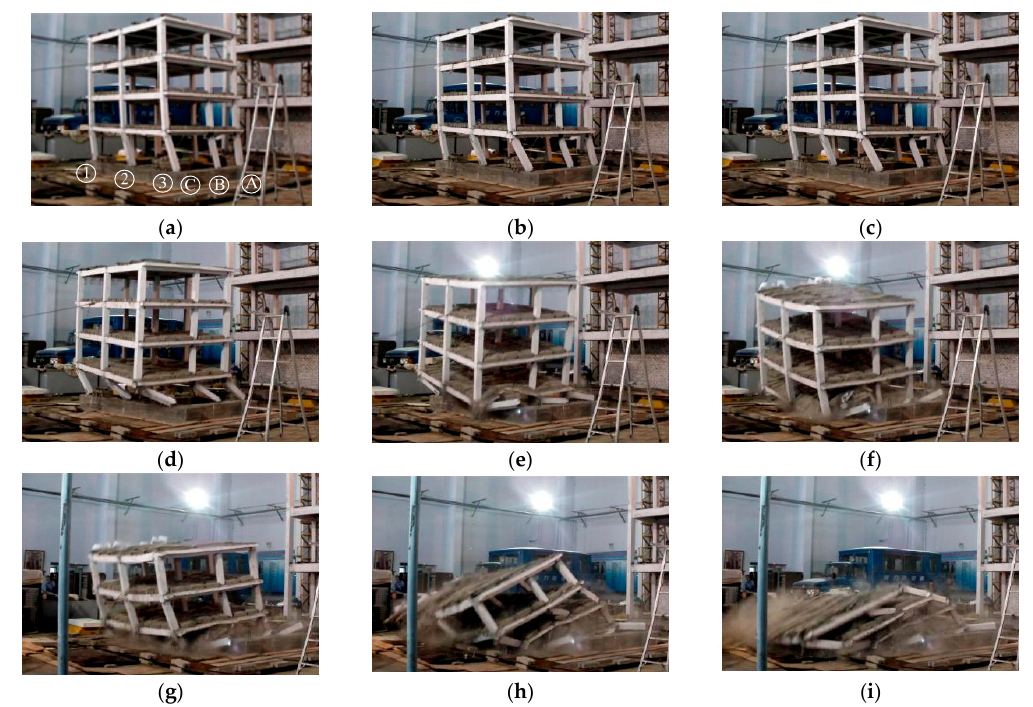
Figure 14. Collapse progress. ( a ) 0 s; ( b ) 0.66 s; ( c ) 0.759 s; ( d ) 0.792 s; ( e ) 0.858 s; ( f ) 0.924 s; ( g ) 1.023 s; ( h ) 1.155 s; ( i ) 1.188 s.